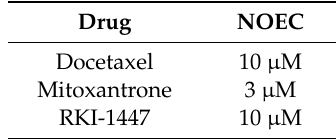
Table 1. NOEC of selected